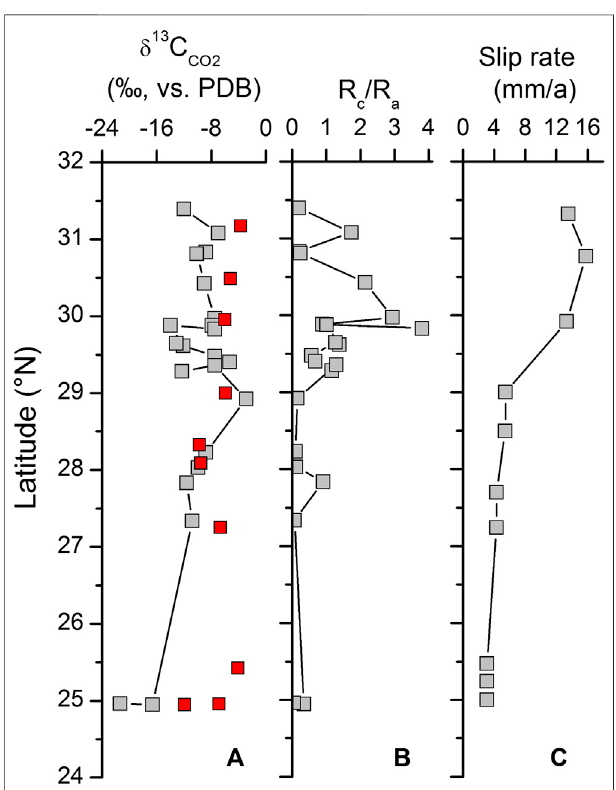
FIGURE 8 | Variations of δ 13 C CO2 values (A) , R c /R a ratios (B) , and fault slip rates (C) from north to south in the XXFS. The colour symbols are data reported in this study. The grey symbols are data reported by previous studies. Data sources: Chen (2006), Shen et al. (2007), Shi et al. (2012), Zhou et al. (2015), and Yue et al.